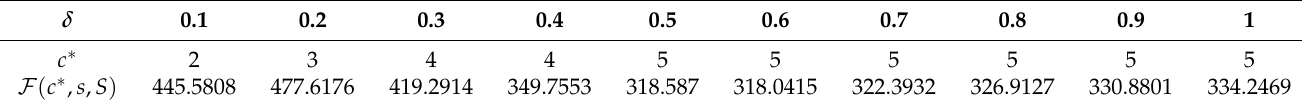
Table 11. Optimal server c ∗ and corresponding minimum cost for ( S , s , η , λ , µ ) = ( 30,12,2.6,5,7 ) .